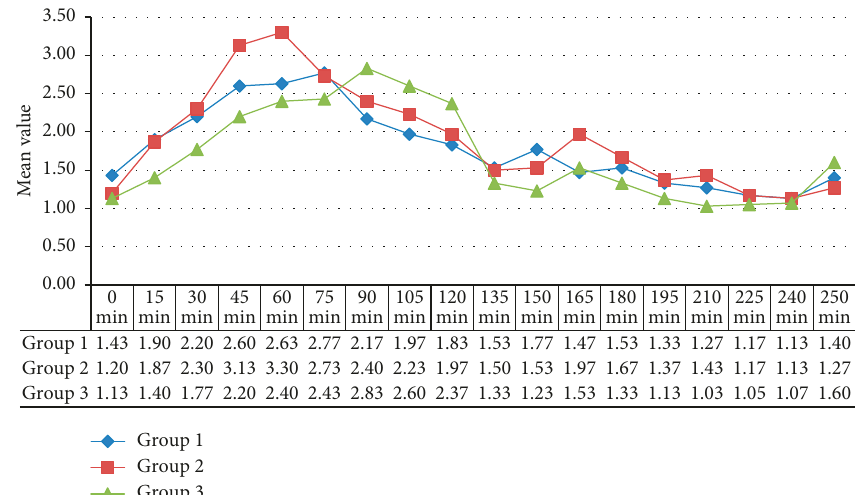
Figure 2: Mean modified Hannallah pain scores of the three drugs: group 1 (levobupivacaine); group 2 (ropivacaine); group 3 (bupivacaine) over the observation period.